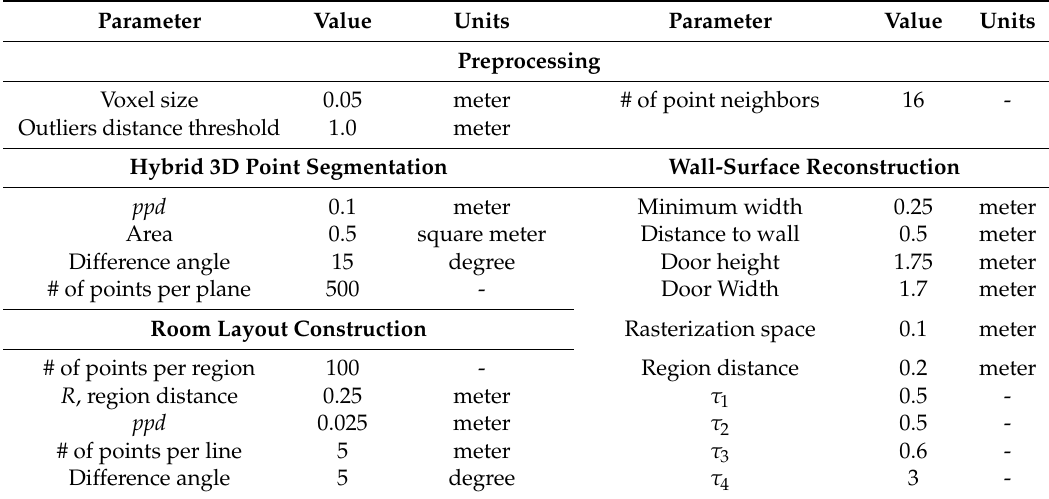
Table 2. Parameters used in the proposed approach. Ppd , projected perpendicular